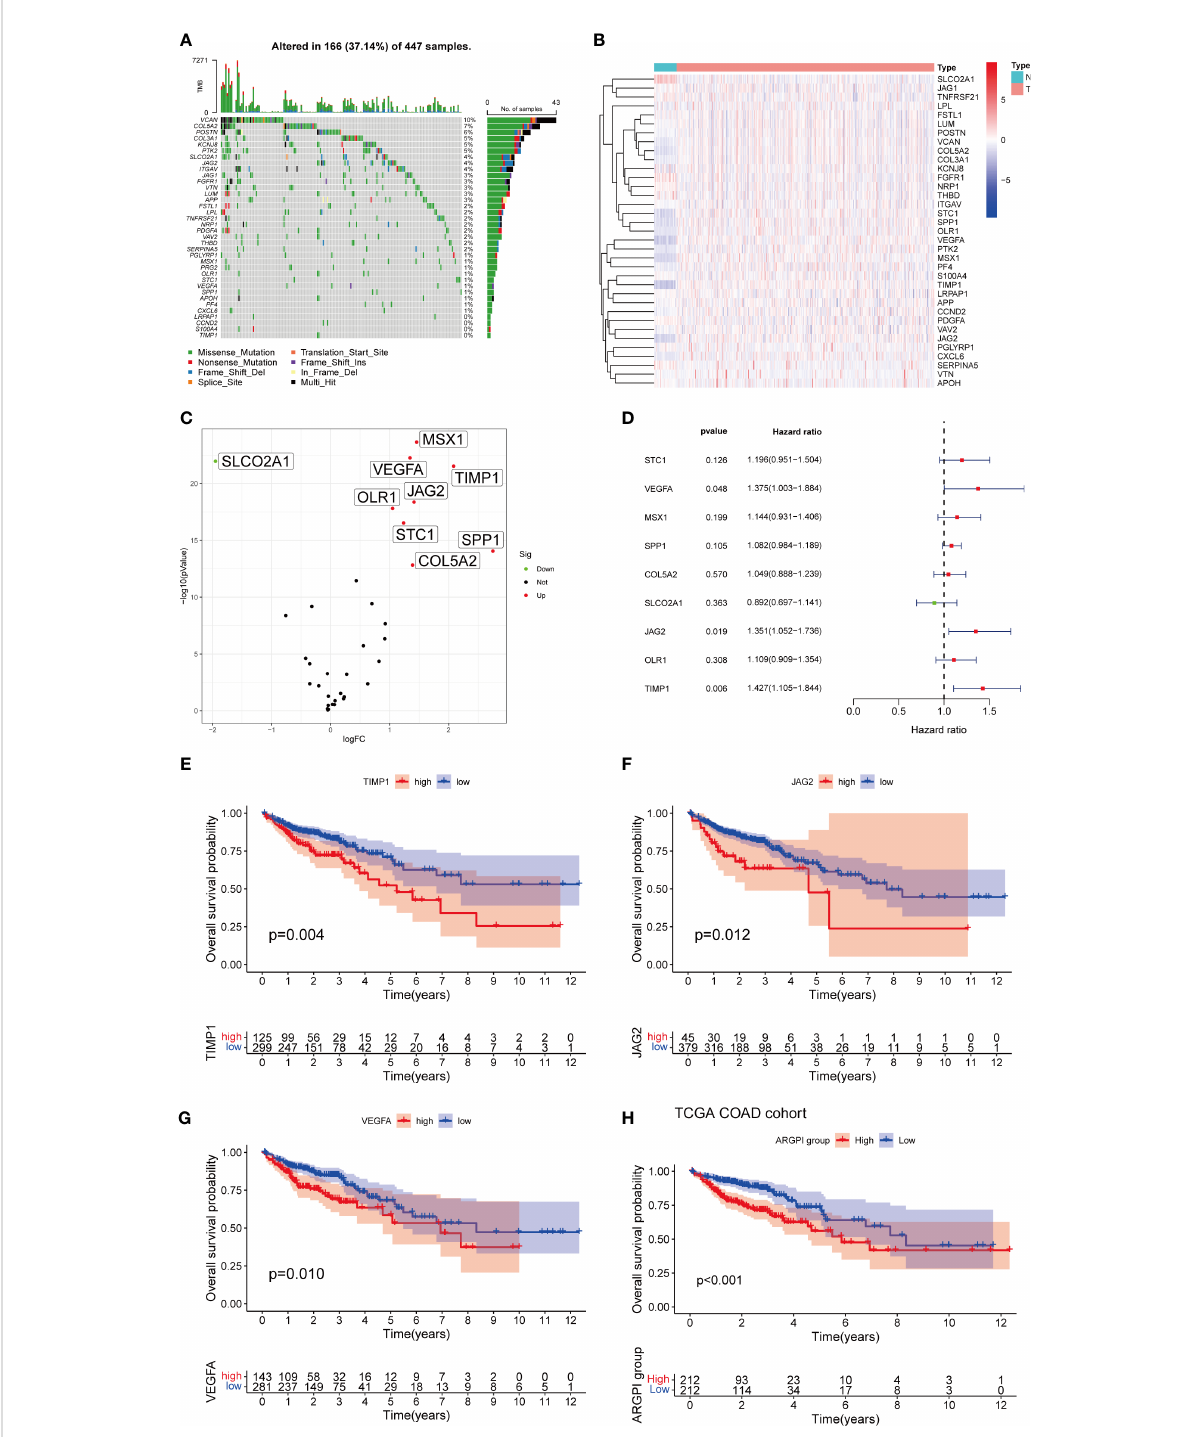
FIGURE 1 Construction of ARGPI. (A) 35 ARG mutation spectrum. (B, C) Heatmap and volcano plot of expression differences of 35 ARG between COAD and normal tissues. (D) Univariate Cox Analysis of 10 DEARG. (E – G) Kaplan-Meier survival analysis of three signi fi cant ARG in univariate Cox analysis. (H) Kaplan-Meier survival analysis of ARGPI subgroups in the TCGA-COAD